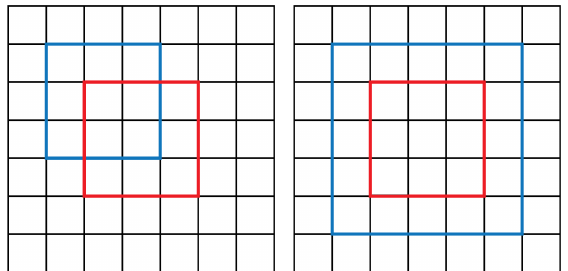
Figure 8. Examples of motion detection: the grid represents the pixels of the scene, the blue rectangle define the current bounding box for the reference object and the red rectagle define the position of the same bounding box at the previous instant. On the left, the system detect a motion due to either a pan of the target or a pan of the camera along both axis. On the right, the system detect a motion due to either a zoom out of the camera or the camera moving away from the target or the target moving away from the